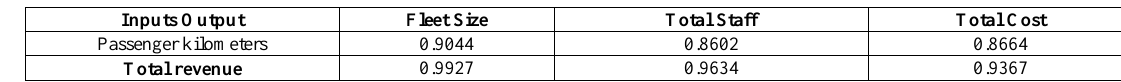
Table 2. Correlation between the input and output